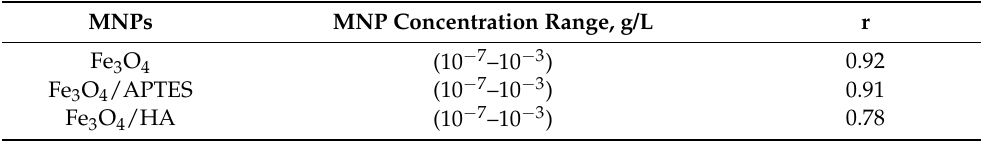
Table 4. Correlation coefficients, r, between dependencies of I rel Bq and ROS rel Bq on MNP concentrations.